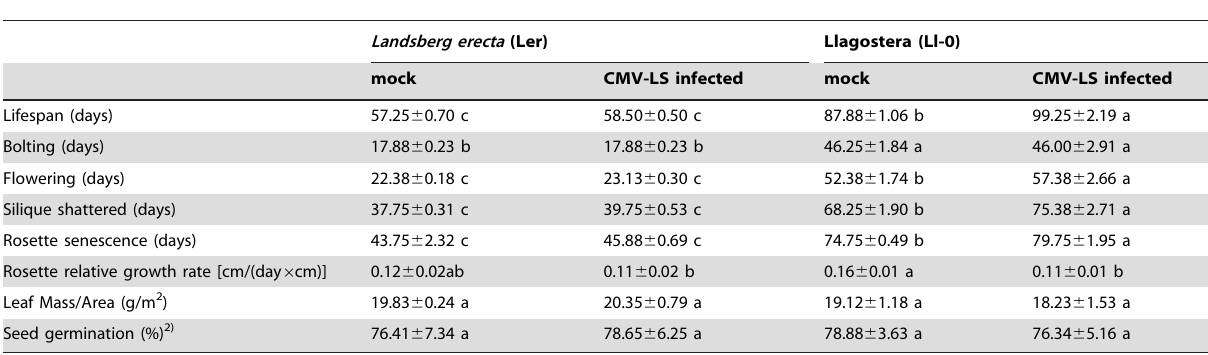
Table 1. Phenotypic traits of two Arabidopsis genotypes 1)